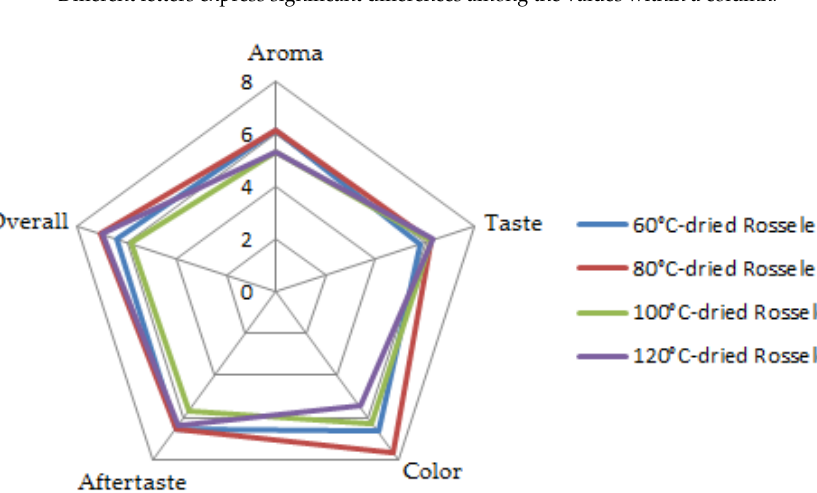
Table 3. Effects of brewing water temperature on the characteristics of the Roselle tea.